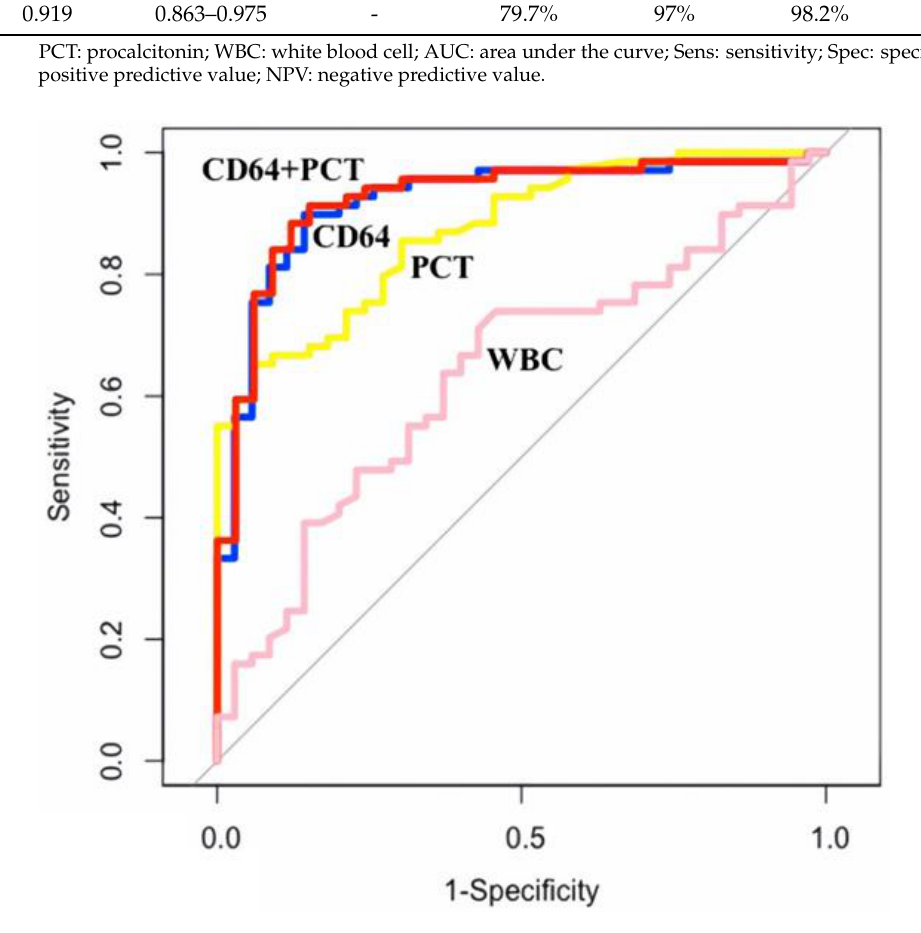
Figure 3. ROC curves comparing sepsis diagnostic abilities of nCD64 to PCT, WBC, and nCD64 combined with PCT. Table 3. Sepsis diagnostic values of nCD64, PCT, and WBC among 104 study participants.